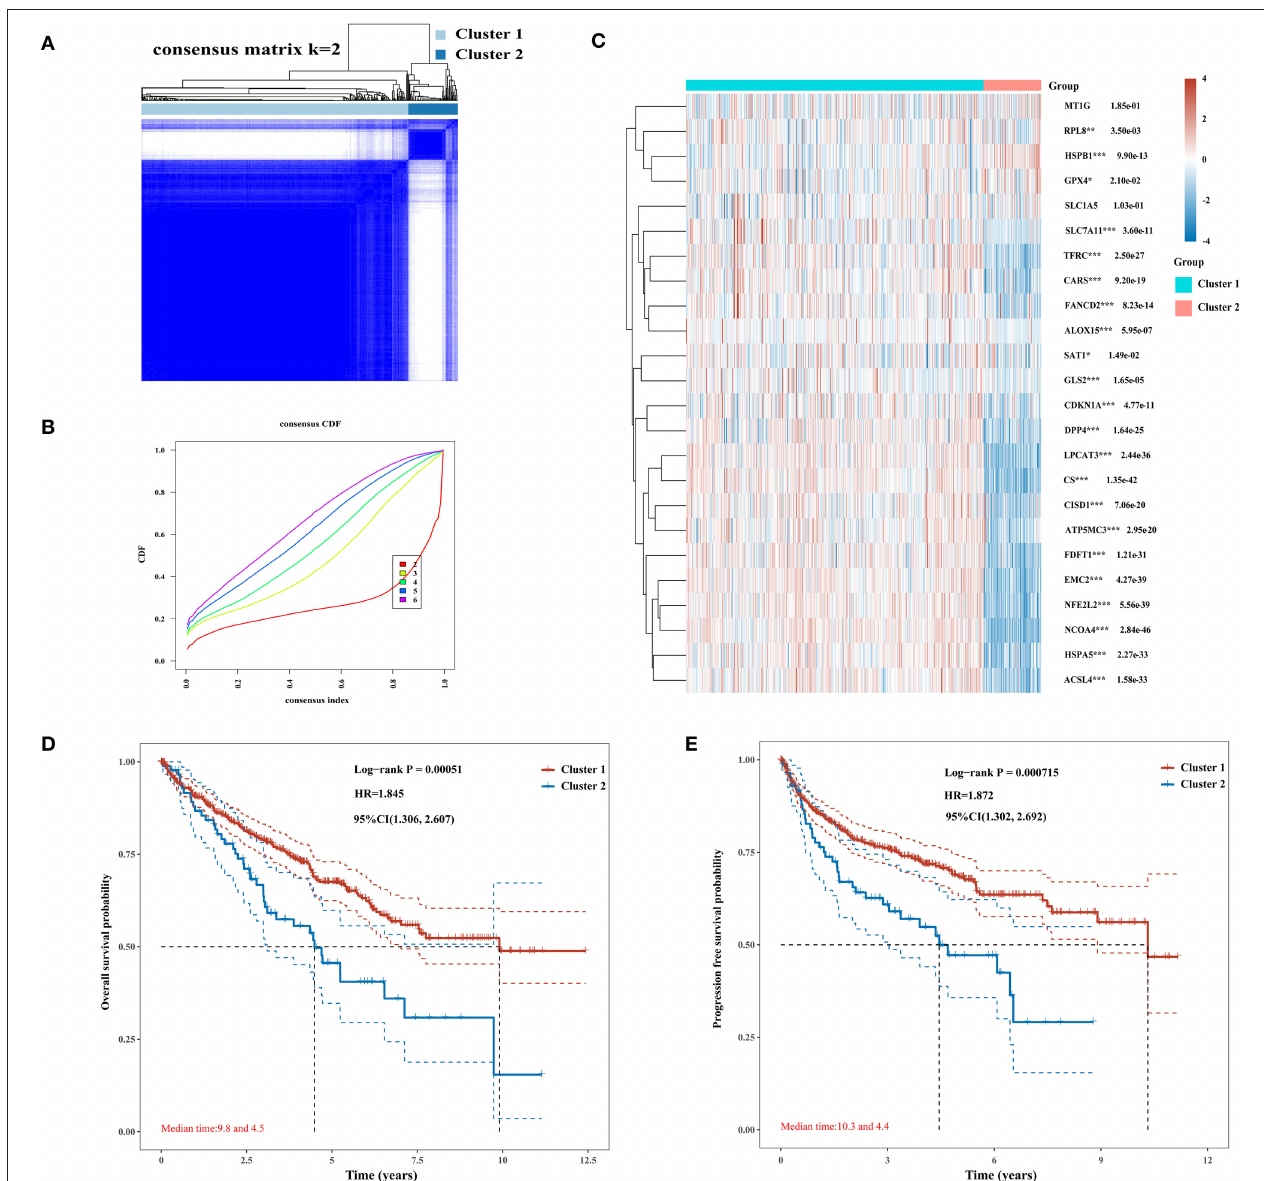
FIGURE 2 | Differential expression pattern of ferroptosis regulators and survival in two clear cell renal cell carcinoma (ccRCC) subtypes. (A) Consensus clustering matrix for k = 2. (B) Cumulative distribution function curves for k = 2–6. (C) Heat map visualized the expression patterns of ferroptosis regulators in two ccRCC subtypes or clusters. (D,E) The Kaplan–Meier curves show the overall survival (D) and the disease-free survival (E) for two clusters of ccRCC patients. * p < 0.05, ** p < 0.01, and *** p <